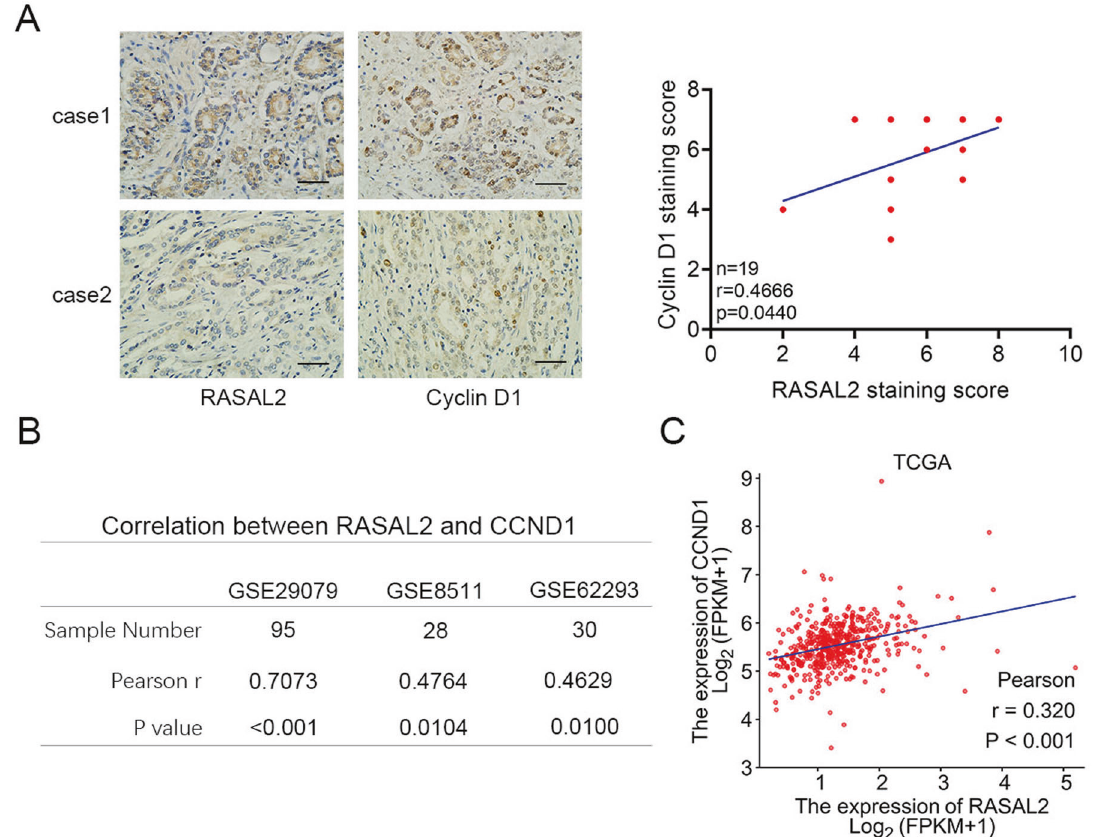
Fig. 6 Correlation of RASAL2 and cyclin D1 in clinical specimens. A Immunohistochemical analysis of the expression levels and correlation of RASAL2 and cyclin D1 in clinical samples of PCa ( n = 19). B Molecular correlation analysis of RASAL2 and cyclin D1 (CCND1) from the GEO database (GSE29079, GSE8511 and GSE62293). C Correlation analysis of RASAL2 and cyclin D1 (CCND1) from TCGA